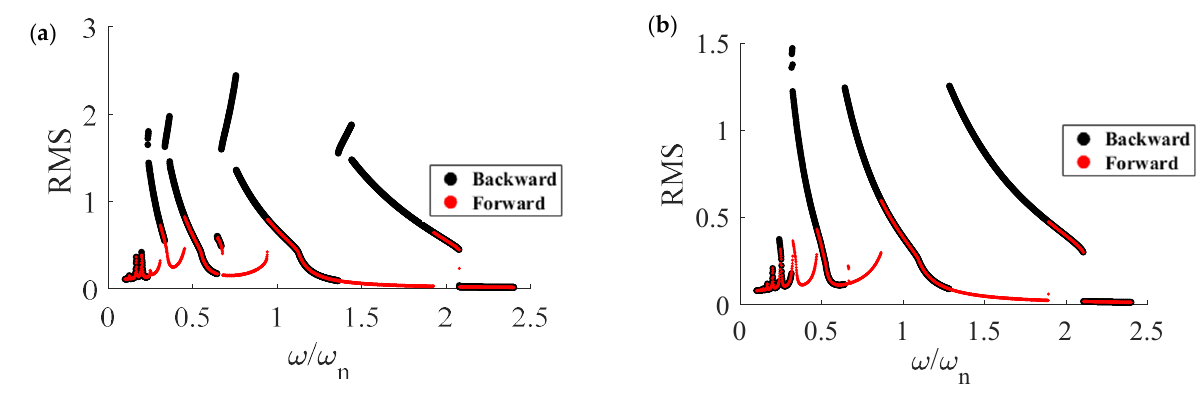
Figure 9. RMS diagram, ( a ) case 2, ( b ) case 3.